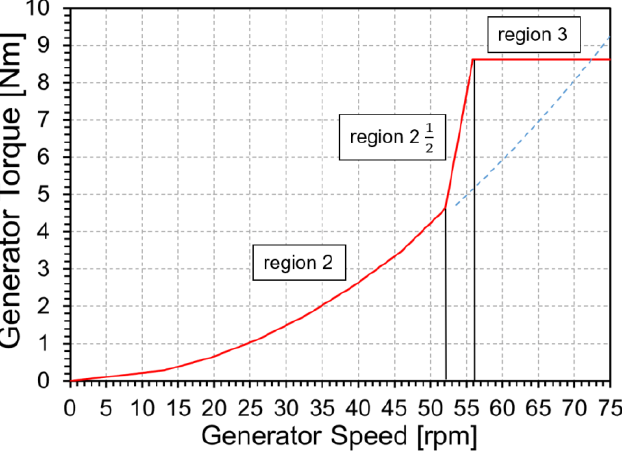
Figure 6. Variable-speed turbine operating regions.